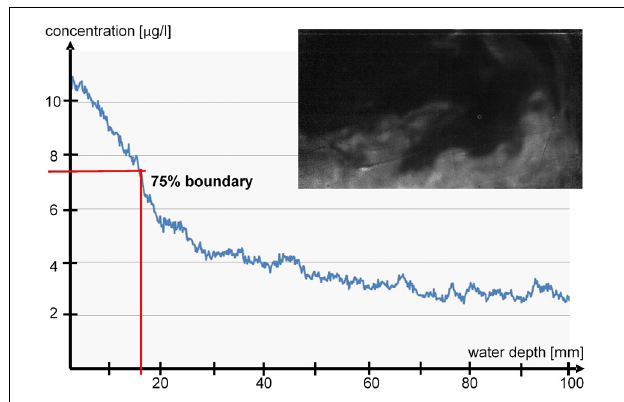
FIGURE 8 | Thickness of the groundwater boundary layer in lab experiment derived from the concentration profile of the laser induced fluorescence (LIF) tracer in the discharged groundwater. The profile was derived from a horizontal averaging of the LIF-tracer concentration maps (example map displayed